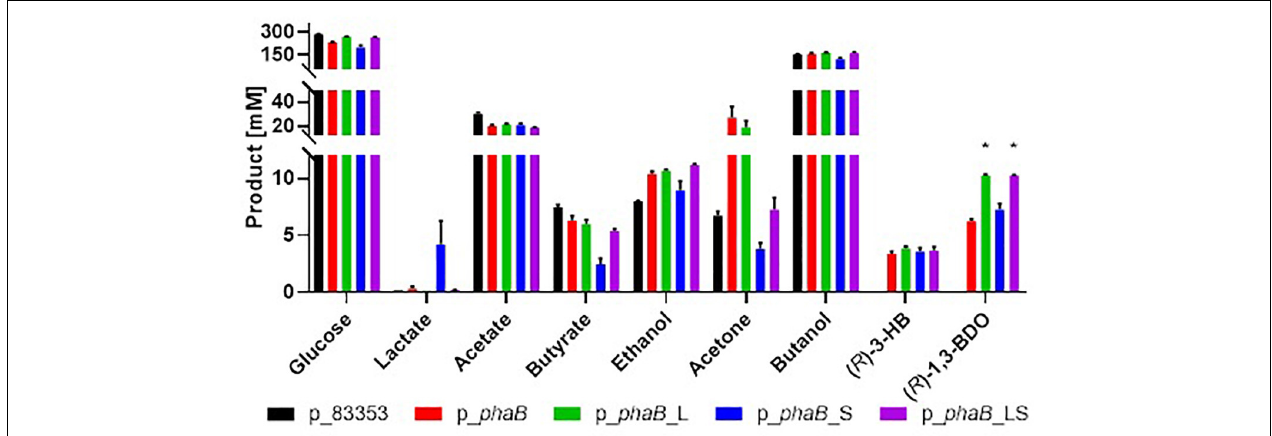
FIGURE 3 | Comparison of product spectrum of Cupriavidus necator wild type phaB and the derivatives with point mutations and negative control without phaB (p_83353) expressed in C. saccharoperbutylacetonicum after 48 h. From left to right for each product p_83353 in black, p_ phaB in red, p_ phaB _L in green, p_ phaB _S in blue, p_ phaB _LS in purple. For glucose the consumed amount is shown for all other the produced amount. Error-bars represent SEM and * represents statistical significance against p_ phaB ( t -test, p < 0.05), n = 3.